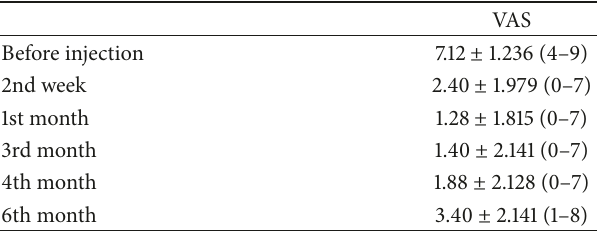
Table 2: The characteristics of the patients according to the pain